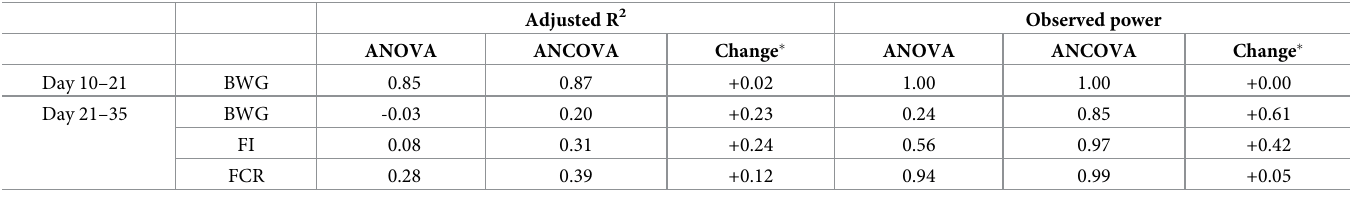
Table 9. Adjusted R 2 and observed power of performance data when analysed by a one-way ANOVA and ANCOVA during different phases for Experiment 3. Adjusted R